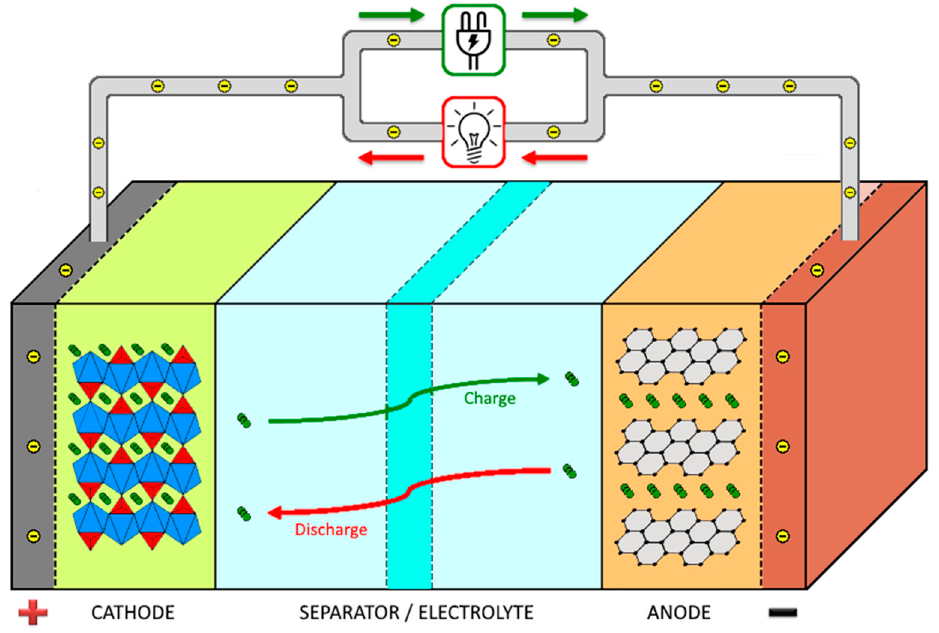
Figure 1. Schematic representation of a lithium ion battery and its working operation.